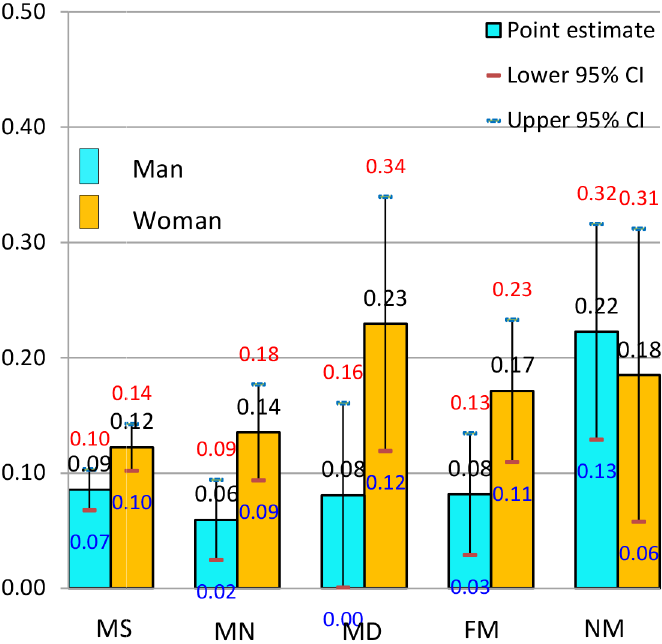
doi:10.1371/journal.pone.0134260.g001